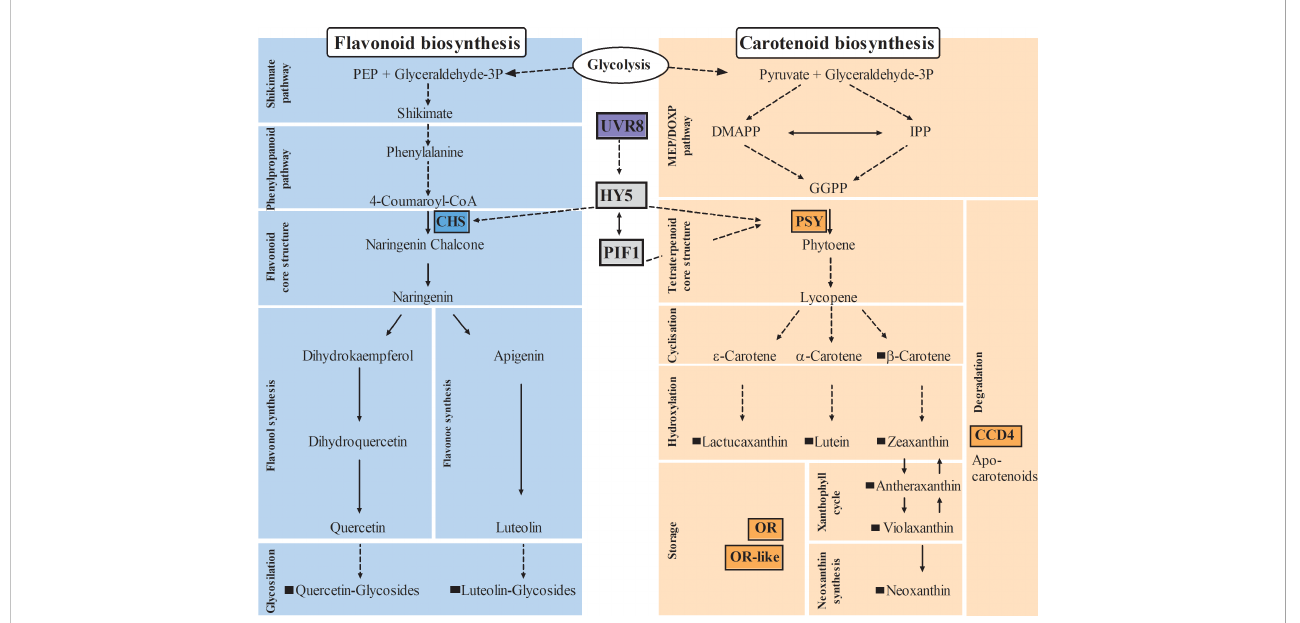
FIGURE 1 Impact on carotenoid and fl avonoid biosynthetic pathways in plants. Arrows with dashed lines indicate more than one reaction, arrows with continuous lines indicate one reaction; key enzymes of fl avonoid and carotenoid pathways are highlighted by colored boxes; black squares indicate metabolites identi fi ed in lettuce in this study. CHS, Chalcone synthase; PSY, Phytoene synthase; CCD4, Carotenoid cleavage dioxygenase4; OR, Orange protein; UVR8, Ultraviolet resistance locus8; HY5, Elongated hypocotyl5; PIF1, Phytochrome interacting factor1; DMAPP, dimethylallyl diphosphate; IPP, isopentenyl diphosphate; GGPP, geranylgeranyl diphosphate; MEP/DOXP, mevalonate/non-mevalonate